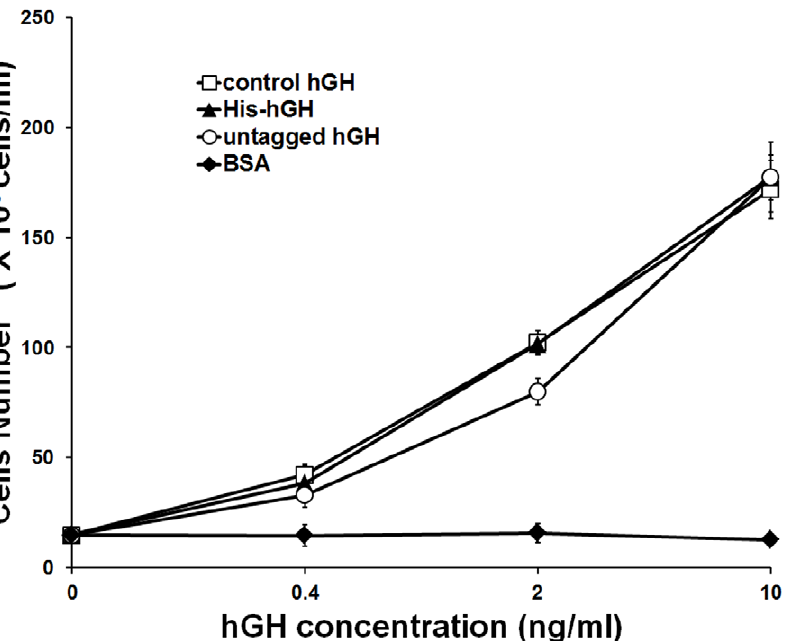
Figure 6. NB2-11 cell proliferation assay of purified hGH. Nb2-11 cells were arrested by serum deprivation and then incubated for 48 h in the presence of control hGH ( % ), His-hGH ( m ), untagged hGH ( # ), or BSA ( X ) at the indicated concentrations. Cell numbers were determined as described in Material and Methods, and averages from three independent experiments are graphed and presented as mean 6 standard error.